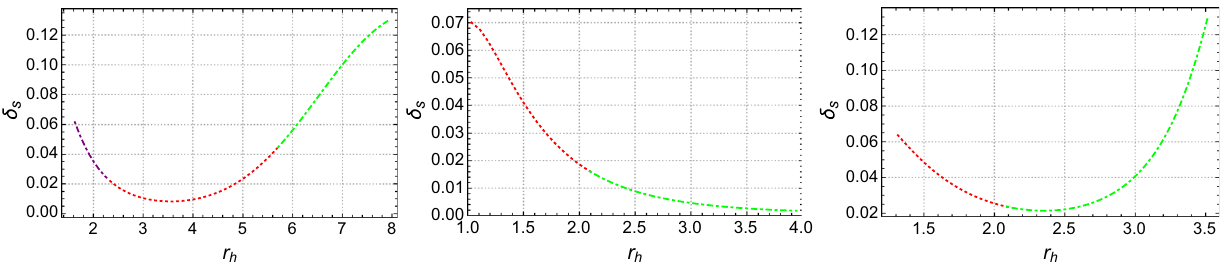
Fig. 7 The variations of the shadow radii with respect to the event horizons for the Kerr-AdS black holes (left, J = 1 , r O = 300 , (cid:13) = − 0 . 03), the Kerr black holes (middle, J = 1 , r O = 100 , (cid:13) = 0) and the Kerr-dS black holes (right, J = 1 , r O = 5 , (cid:13) = 0 . 03)